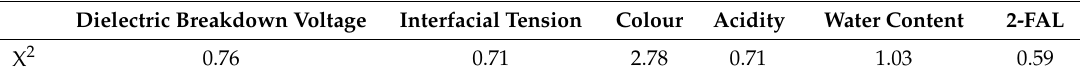
Table 5. Chi-square distribution coefficient for oil quality.